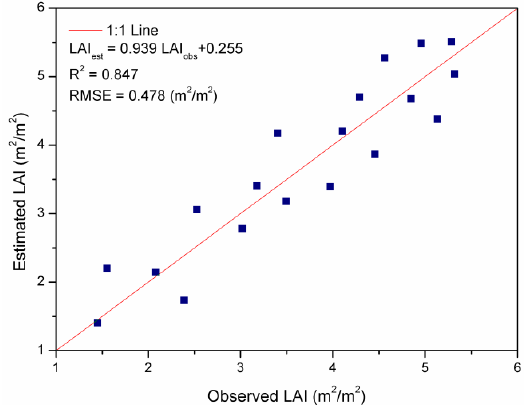
Figure 6. Comparison between observed and estimated values of LAI by SVR.